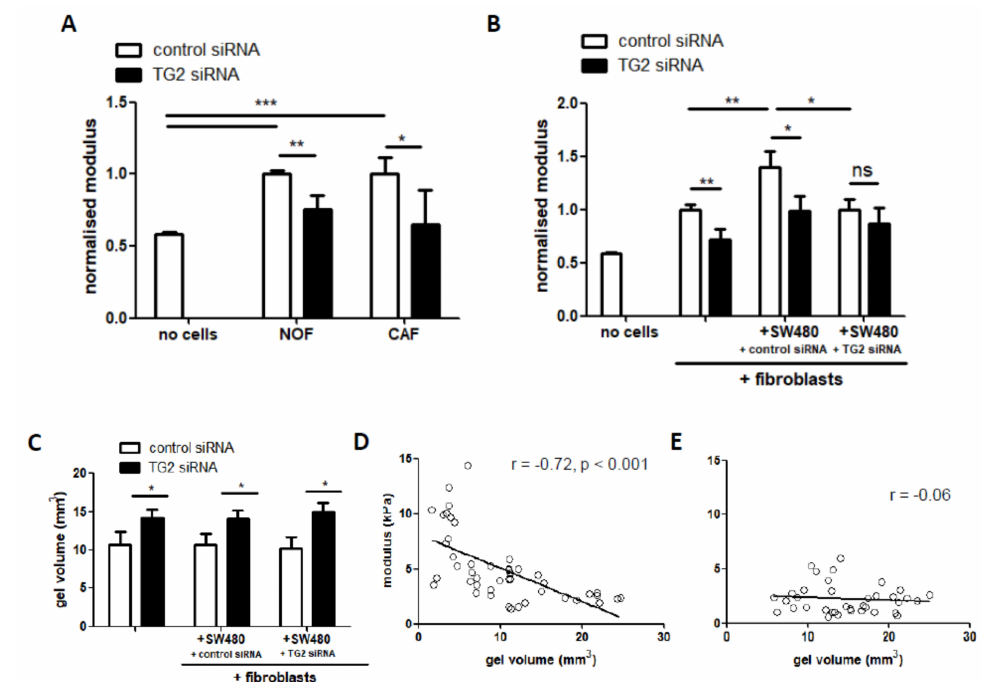
Figure 3. TG2-mediated changes alter the biomechanical properties of CRC / fibroblast co-cultures. Incorporation of fibroblasts into collagen gels significantly increased modulus compared to blank gels ( A , n = 8–11). Silencing of TG2 caused a significant decrease in modulus but no di ff erences between NOFs and CAFs. Co-culture of fibroblasts with SW480 cells resulted in a significant increase in modulus ( B , n = 9–11); however, silencing of TG2 in SW480 cells blocked this increase. Silencing of TG2 in fibroblasts also resulted in a loss of contractile ability ( C , n = 19). A clear correlation between gel volume and modulus was observed in gels incorporating fibroblasts ( D ), but this relationship was lost following silencing of TG2 in the fibroblasts ( E ). * p < 0.05, ** p < 0.01, *** p < 0.001, ns = not